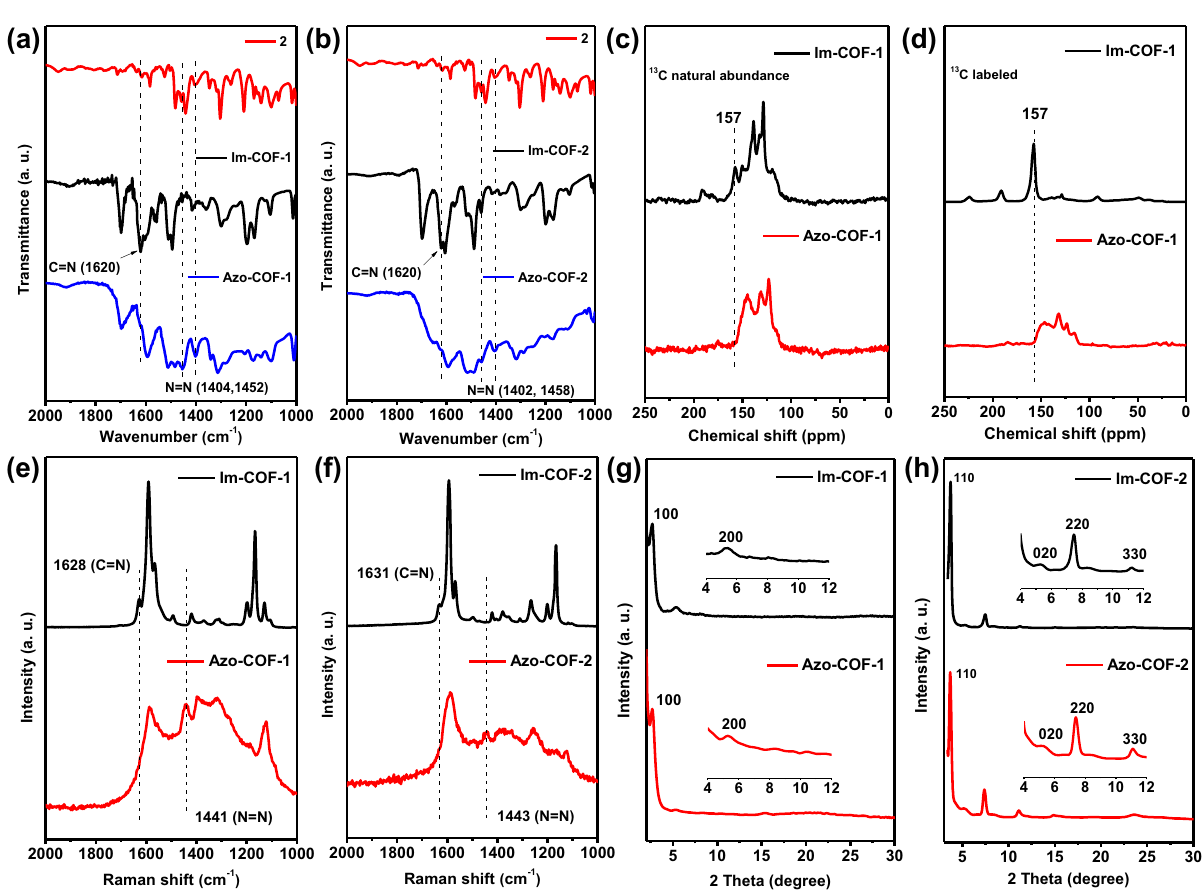
Fig. 2 Characterization of the structural transformation. Comparisons of ( a , b ) FT-IR spectra, ( c , d ) 13 C CP-MAS NMR spectra, ( e , f ) Raman spectra, and ( g , h ) PXRD patterns between the imine-linked COFs and azo-linked COFs.